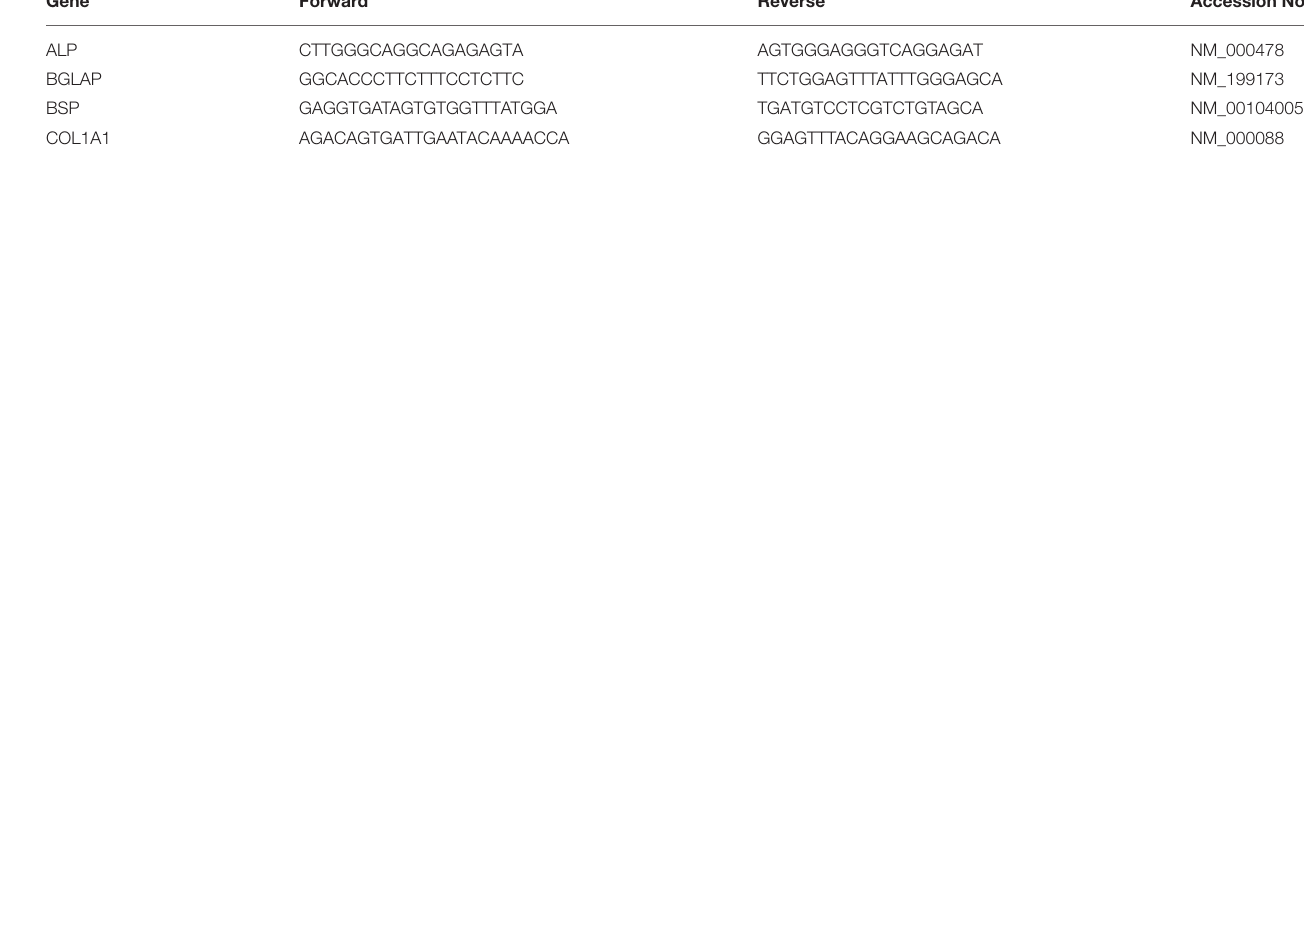
TABLE 1 | Primer sequences and accompanying gene accession numbers.